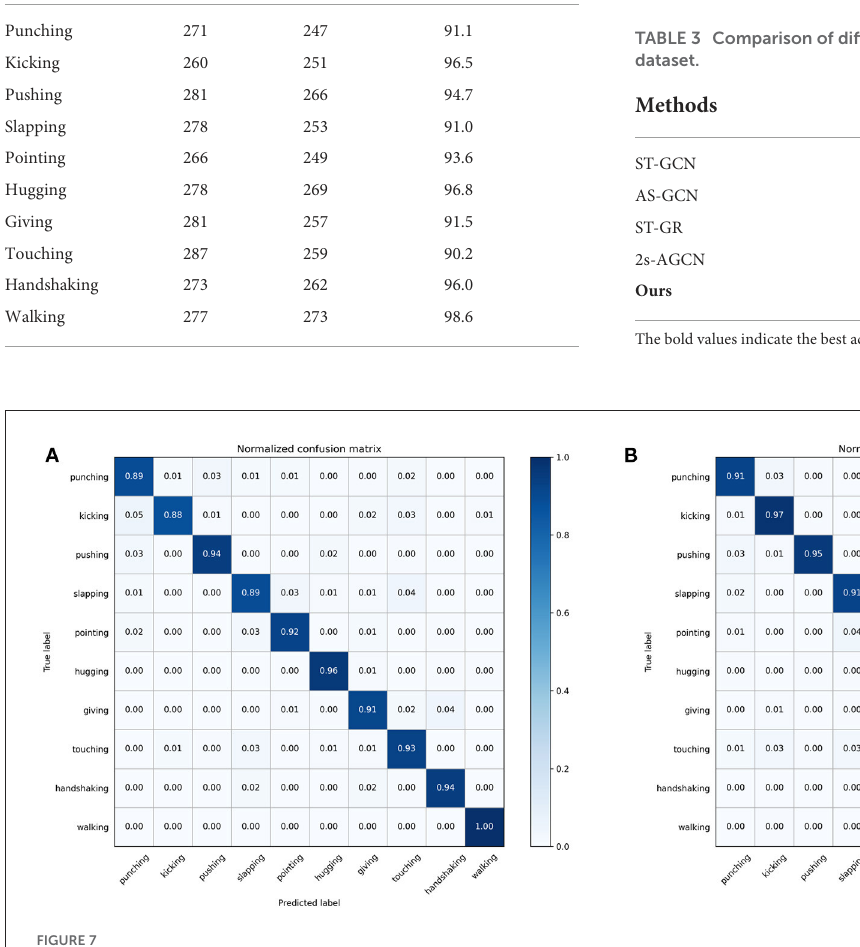
TABLE 2 Comparison of recognition results for 10 types of human action on the Filtered NTU RGB+D dataset. Classes